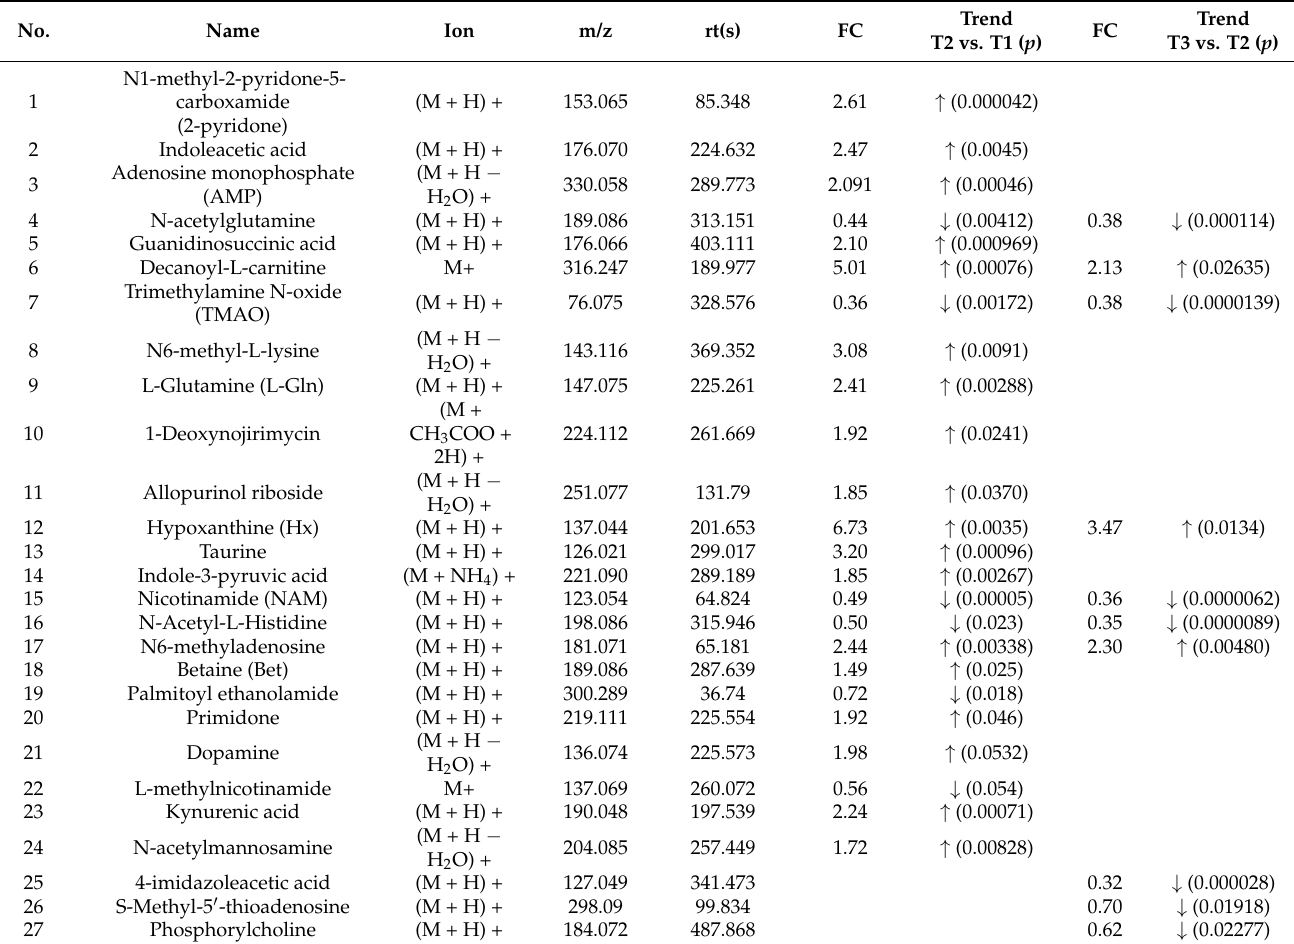
Table 3. Information and trends of differential urinary metabolites at different intervals after water polo